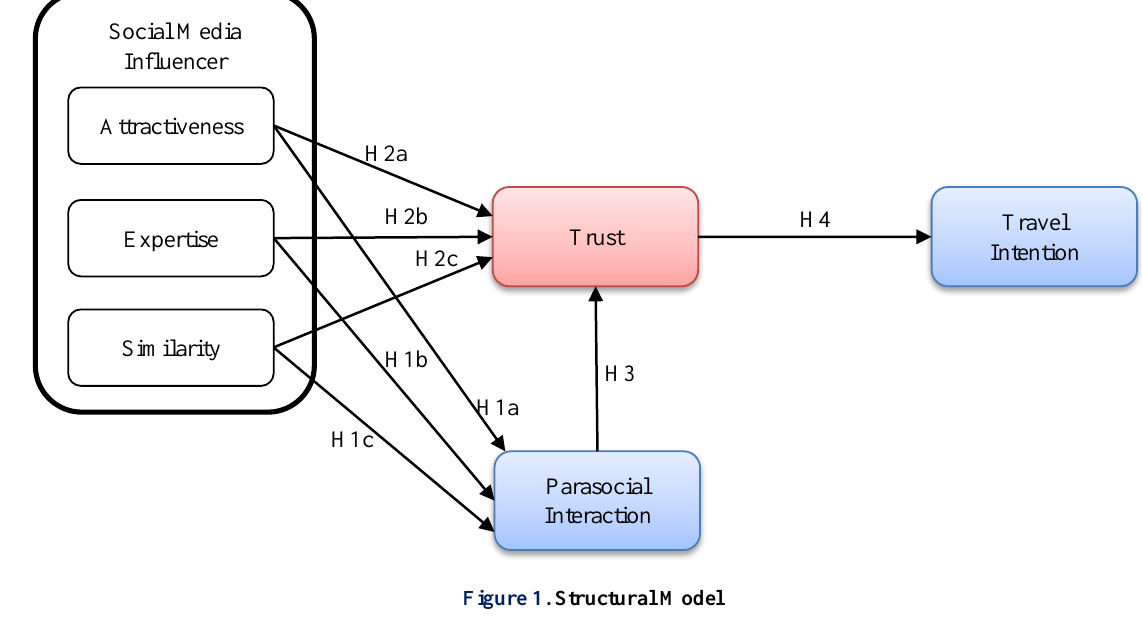
Figure 1. Structural